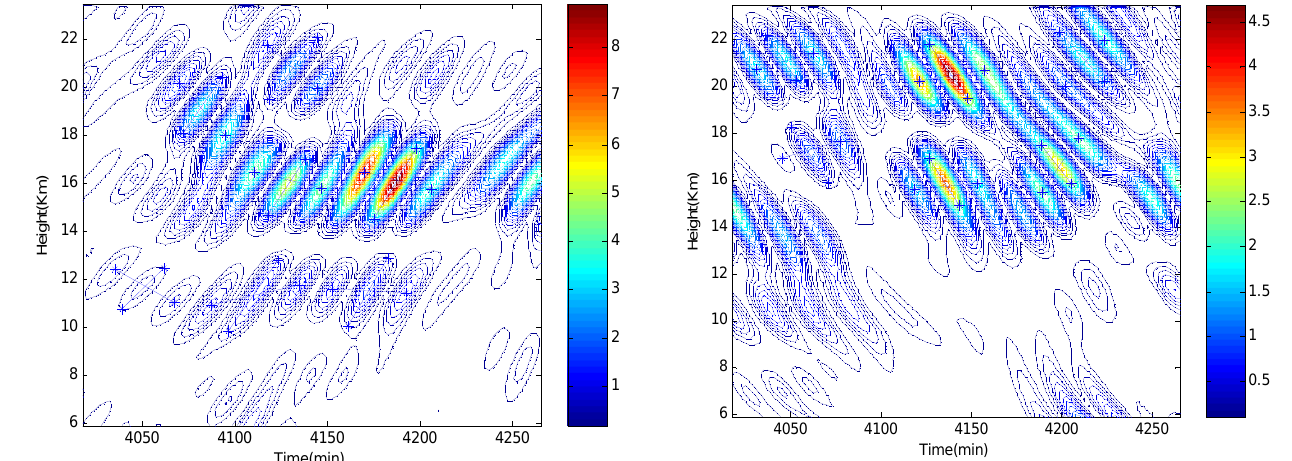
Fig. A2. The range time plot of (δV ) 2 converted from left panel of Fig. A1 by the method of phase- and group-velocity tracing. Seven wave packets were identified and measured from this map.